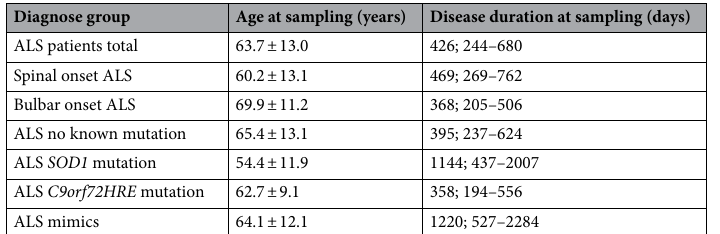
Table 1. Age distribution and disease duration at the time of sample collection. Values are presented as arithmetic mean ± SD or median; Q1–Q3.